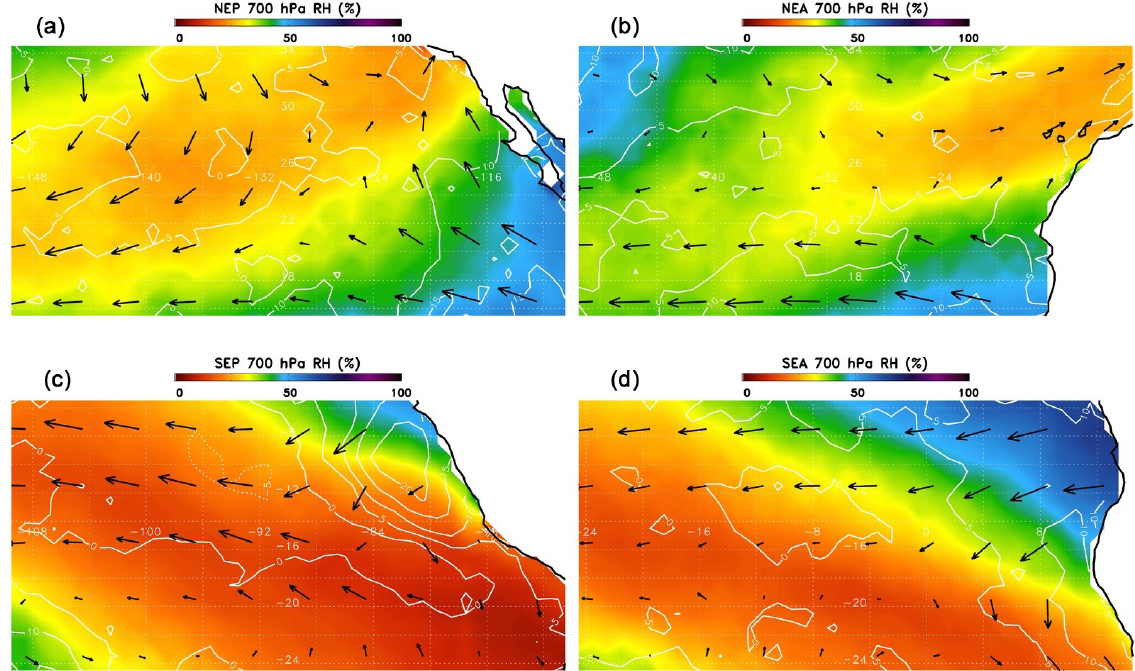
Figure 5. AIRS RH 700 (%) for regions listed in Table 1: (a) NEP, (b) NEA, (c) , SEP, and (d) SEA. The MERRA–AIRS RH 700 difference is shown as white contours (solid implies MERRA is moister, and dashed implies AIRS is moister). The length and direction of the arrows depict the 700hPa wind vectors from